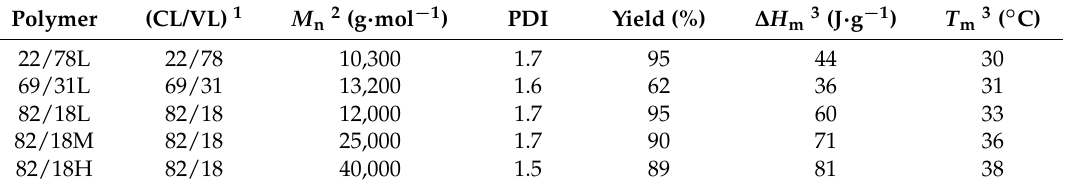
Table 3. Copolymerization of ε -caprolactone with δ -valerolactone using Sn(Oct) 2 in bulk at 140 ◦ C for 6